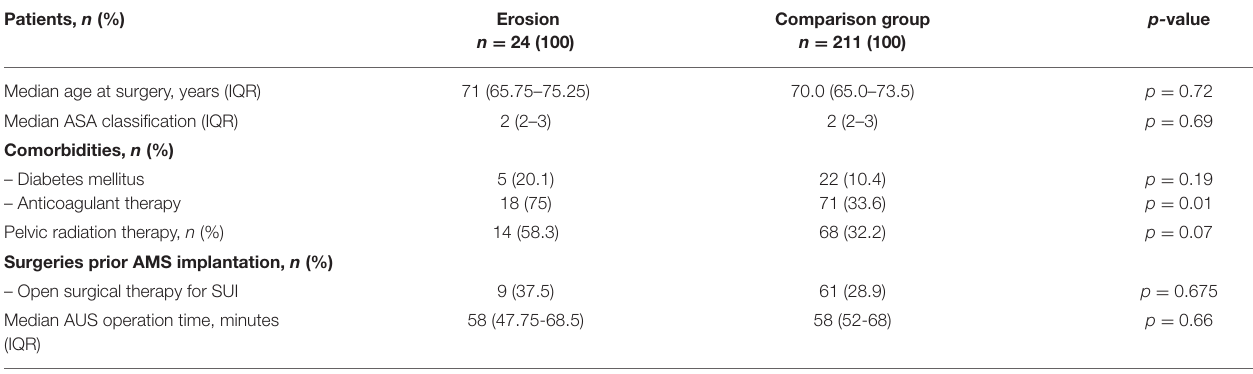
TABLE 1 | Clinical characteristics among patients stratified according to the presence of AUS erosion after AUS implantation. Patients, n (%)